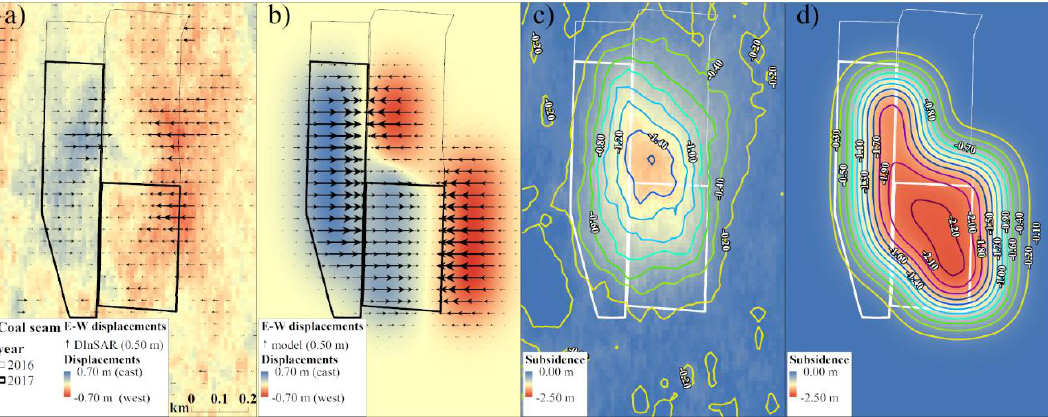
Figure 10. Cumulative surface changes for the entire year of 2017: ( a ) Displacements in the east-west direction from DInSAR, ( b ) from the model, ( c ) vertical subsidence derived from DInSAR, and ( d ) from the model.